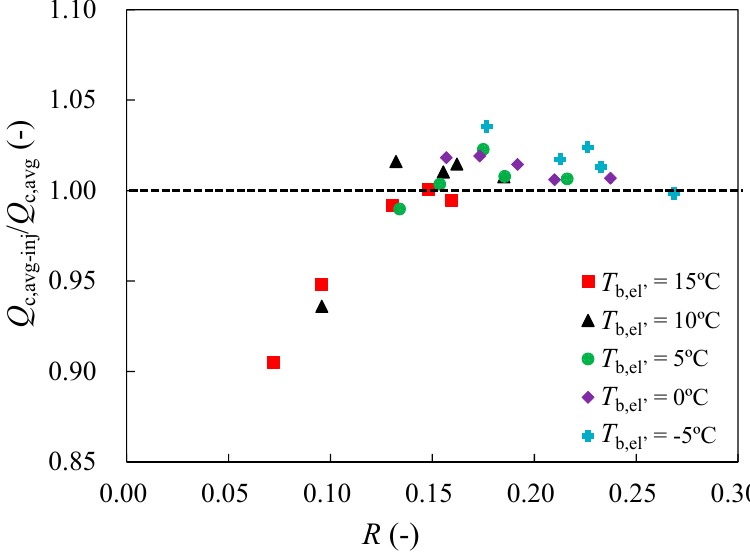
Figure 13. The variation of normalized heating capacity Q c,avg-inj / Q c,avg with the injection ratio R of the vapor injection heat pump cycle.